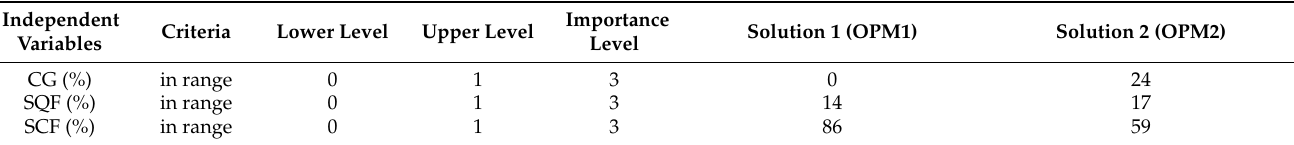
Table 5. Parameters selected for the desirability optimization method, optimal extrudate formulations and predicted values for each response